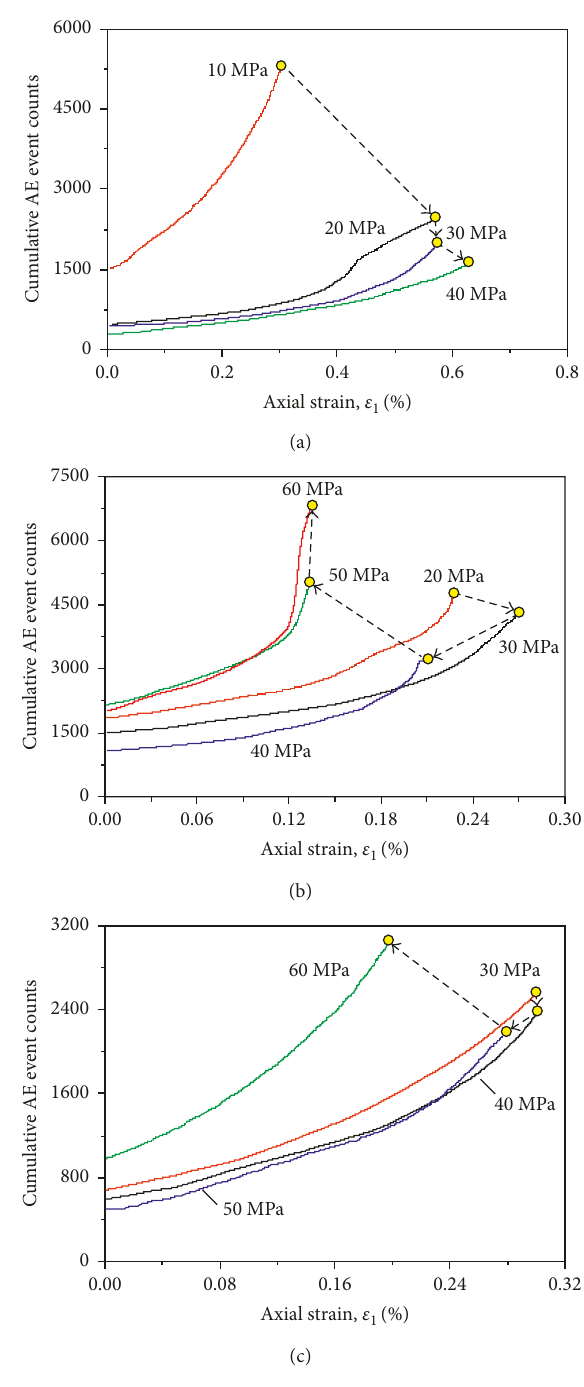
Figure 14: The typical curve of the cumulative number of AE events with the change in strain under different loading